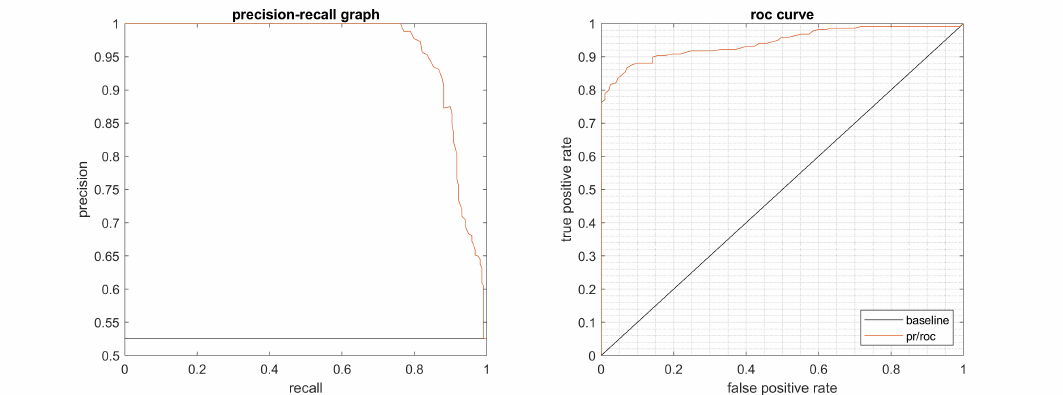
Figure 4. Precision-recall curve and receiver operating curve (ItalianPVS dataset).